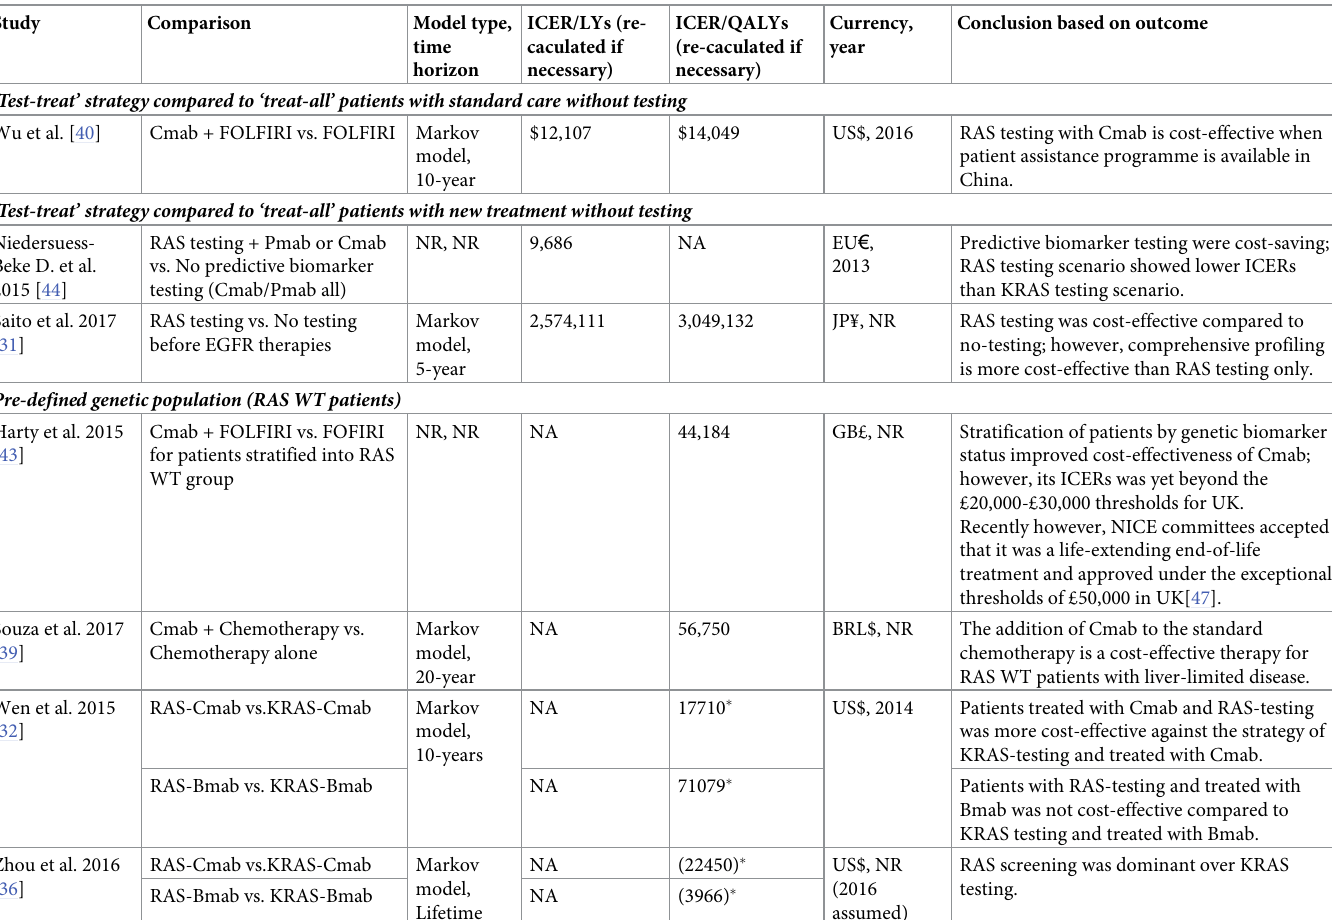
Table 2. Cost-effectiveness finding of RAS testing for corresponding targeted